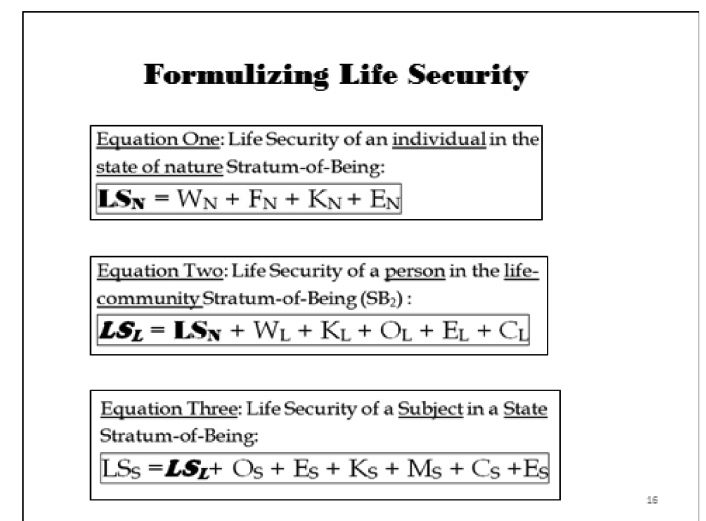
Figure 6: Sequence and accumulation of life security actions in formulaic